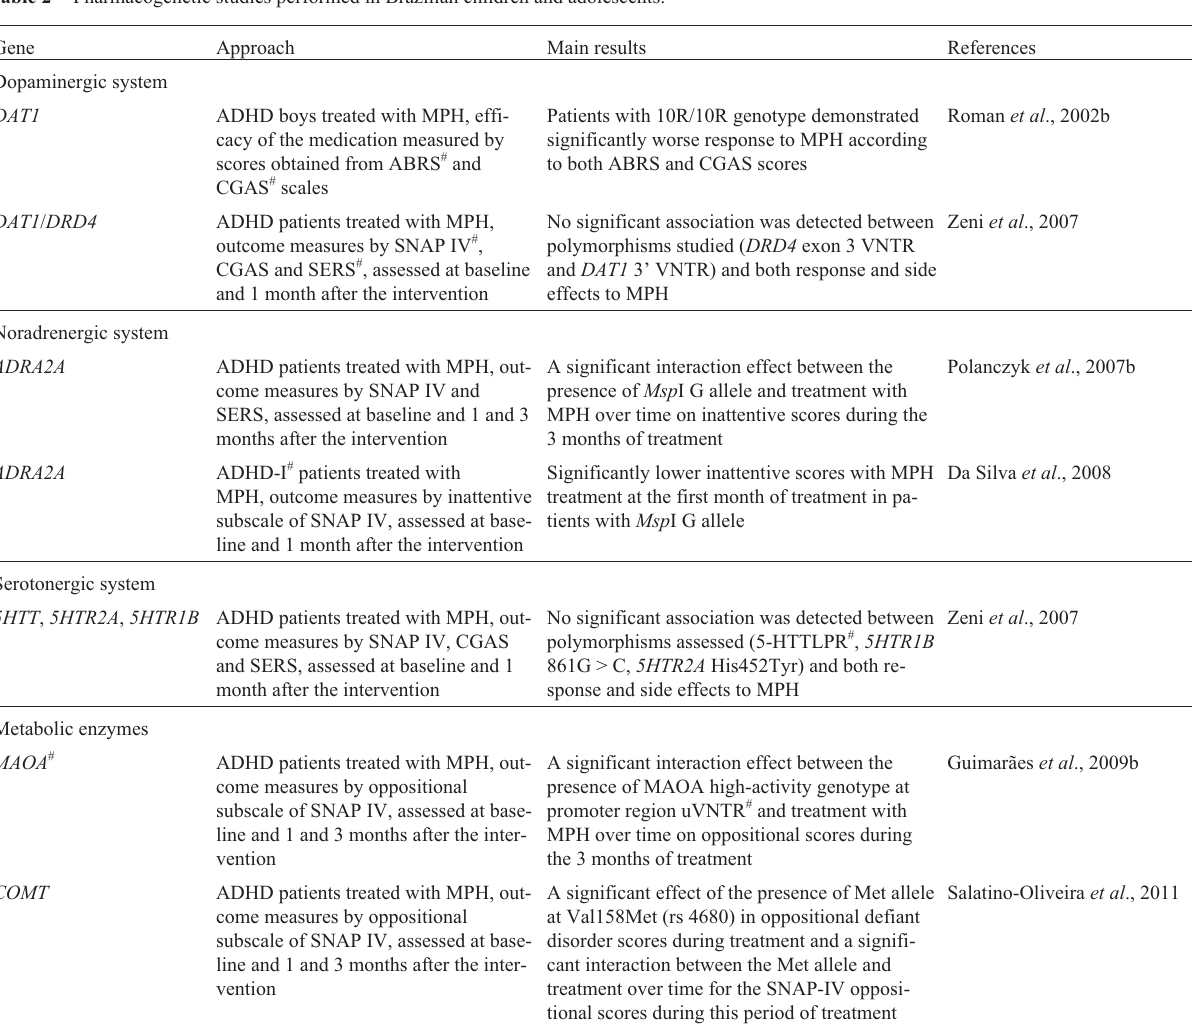
Table 2 - Pharmacogenetic studies performed in Brazilian children and